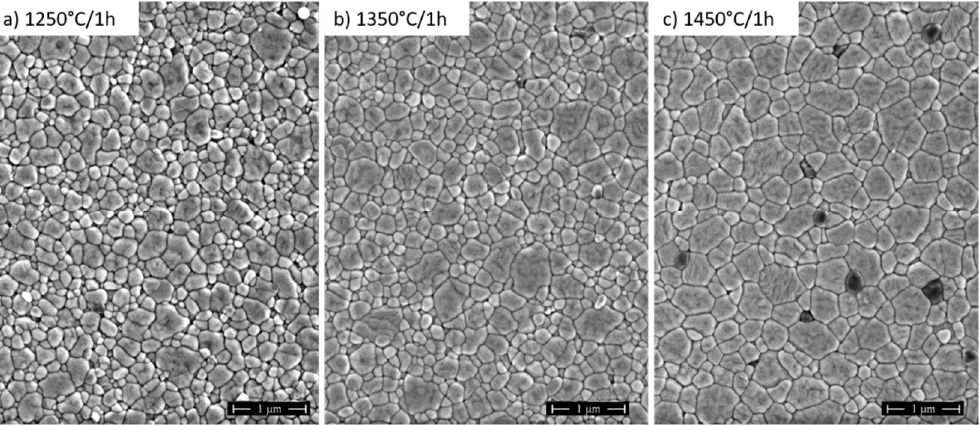
Figure 6. SEM images of thermally etched 2Y-TZP sintered at ( a ) 1250 °C, ( b ) 1350 °C, and ( c ) 1450 °C.